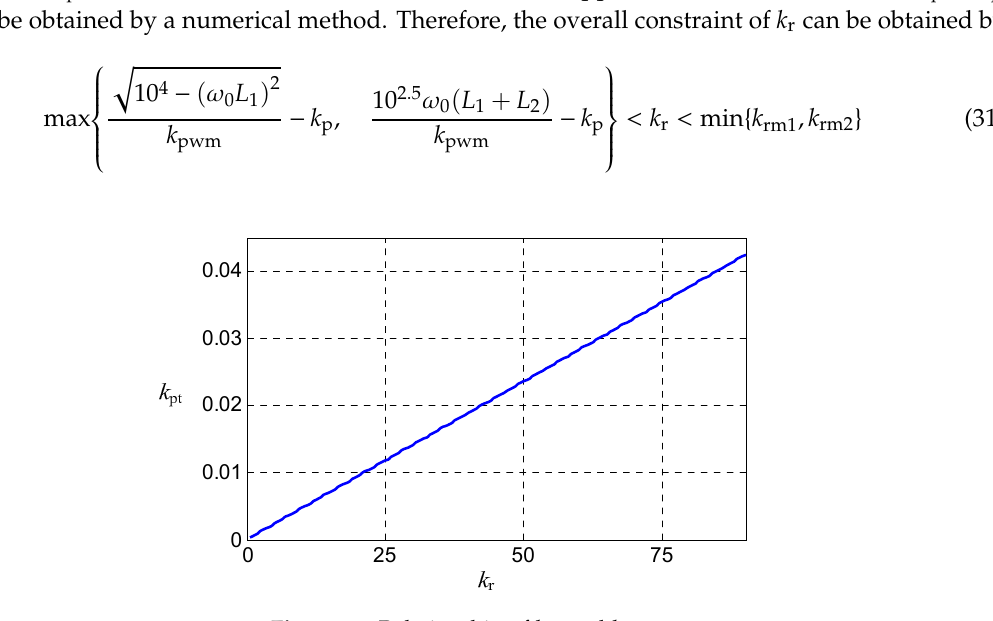
Figure 10. Relationship of k pt and k r .